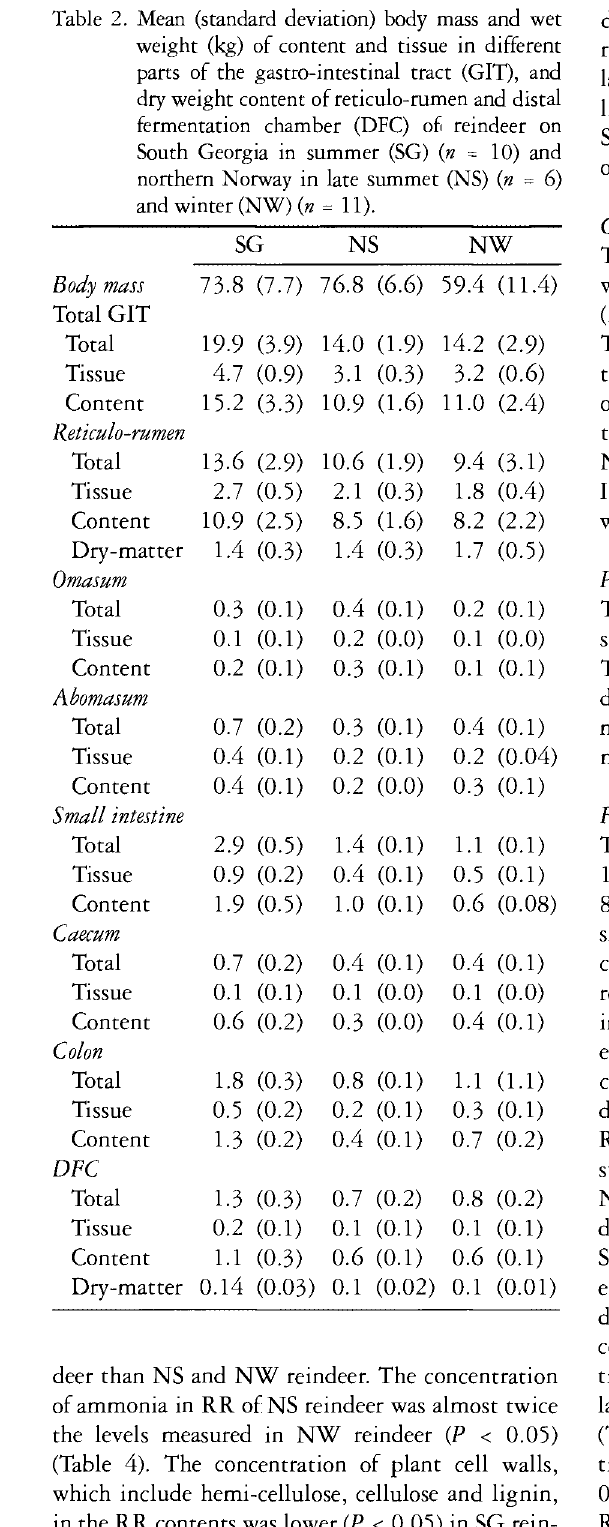
(Table 2; 6; 8). The DFC wet weight content